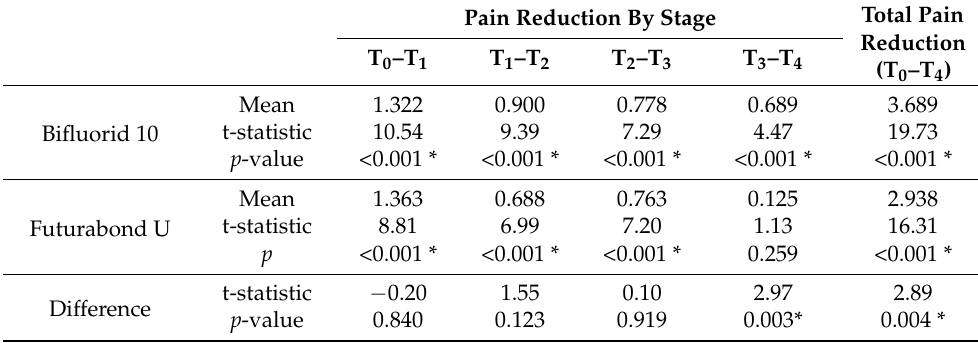
Table 2. Significance of pain reduction at four stages and total pain reduction in Bifluorid 10 and Futurabond U groups and difference between groups according to VAS. Positive value of t-statistic in “Difference” row indicates a higher efficacy of Bifluorid 10, negative values of Futurabond